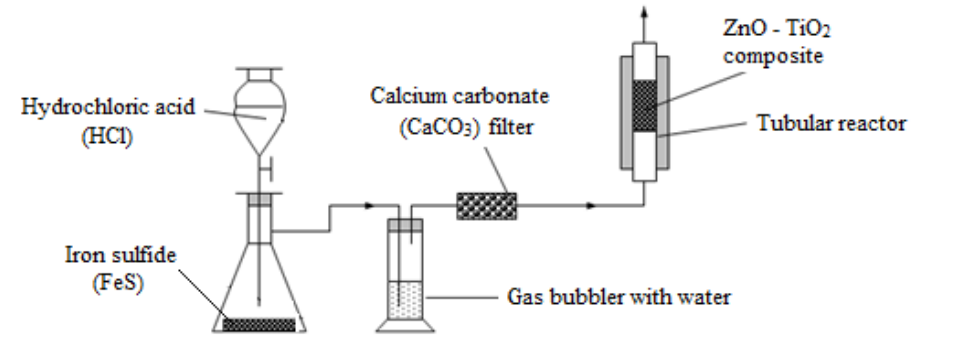
Figure 1. The sketch of the laboratory sulfurization plant.